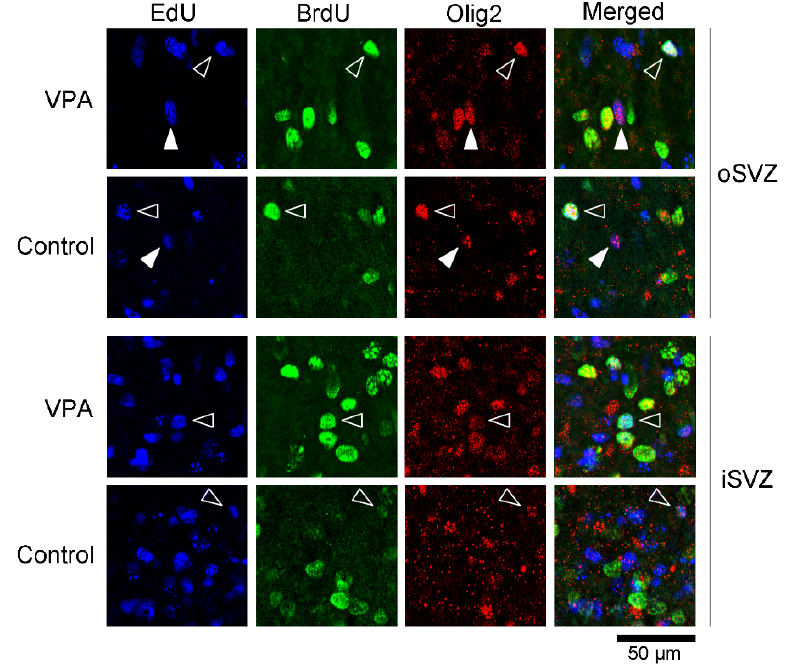
Figure 3. High ‐ magnification images of Olig2 immunofluorescence with EdU and BrdU labeling in the SVZ of the premature cortex of VPA ‐ exposed and control ferrets at PD 7. Open arrowheads, Olig2 ‐ positive progenitors with EdU/BrdU double labeling; closed arrowheads, Olig2 ‐ positive progenitors with EdU single labeling.